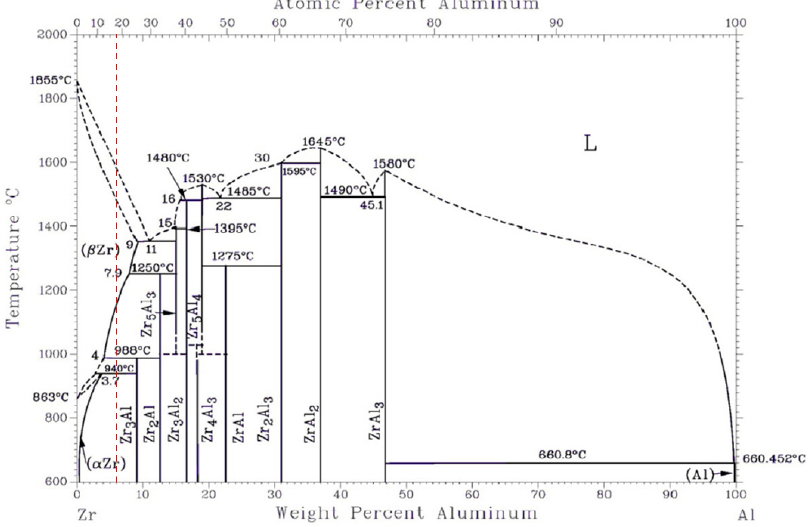
Figure 2. Phase diagram of Zr-Al binary alloy.